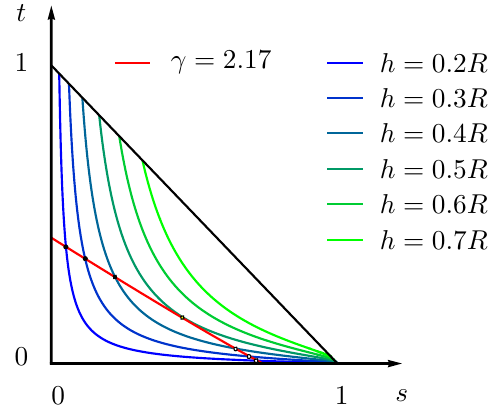
Figure 1 . For a given (cid:13) and di(cid:11)erent values of h , black and white bullets represent stable and unstable solutions respectively. The yellow bullet represent a critical case for which constant (cid:13) and constant h becomes tangent.